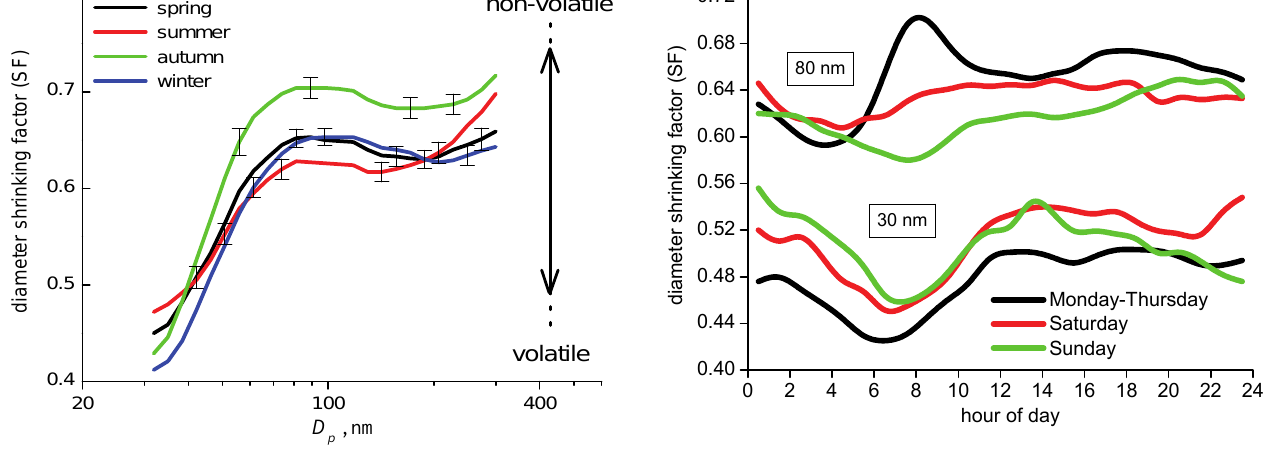
Fig. 8. Particle diameter shrinking factor (SF) due to thermodes- orption at 300 ◦ C. The data cover the morning traffic peak hours (06:00–09:00CET) and are keyed after season. Whiskers represent plus/minus one sigma of the mean.